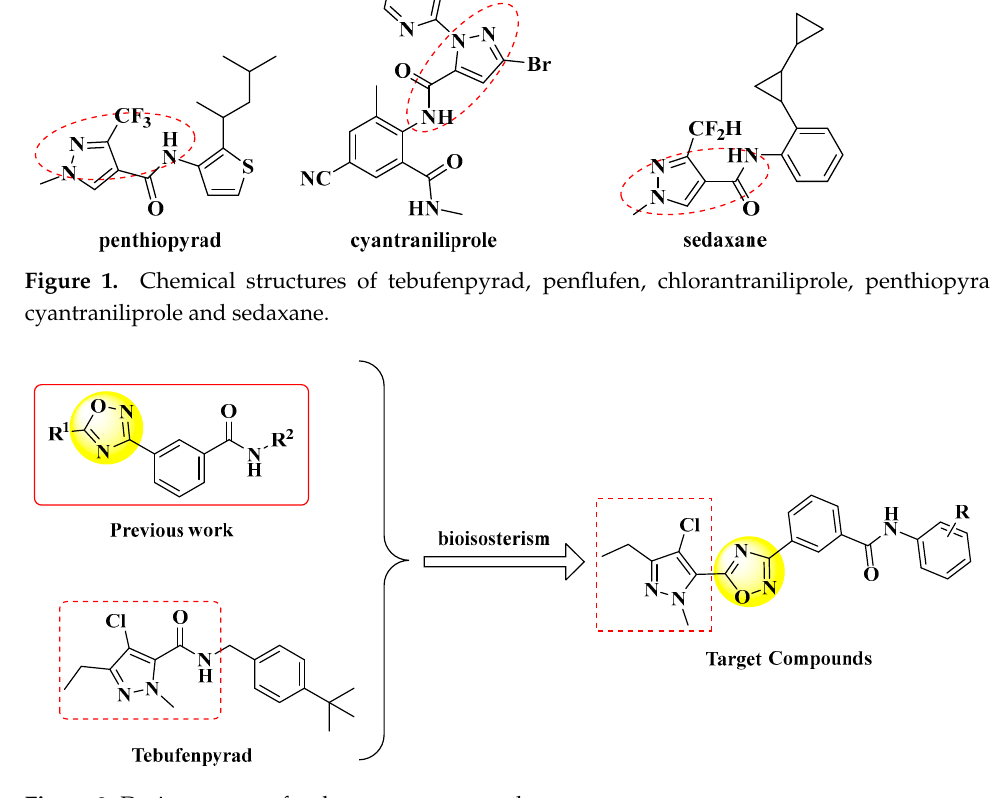
Figure 2. Design strategy for the target compounds.